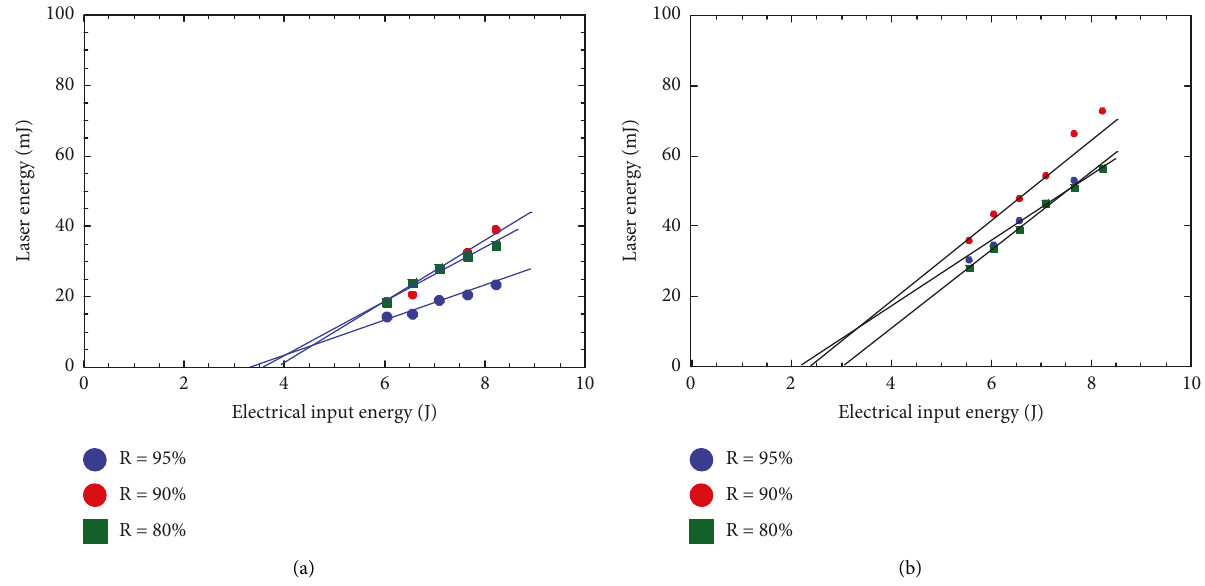
Figure 9: Measured output laser energy. (a) Cr/Nd :YAG ceramic laser. (b) Ce/Cr/Nd: YAG ceramic laser.